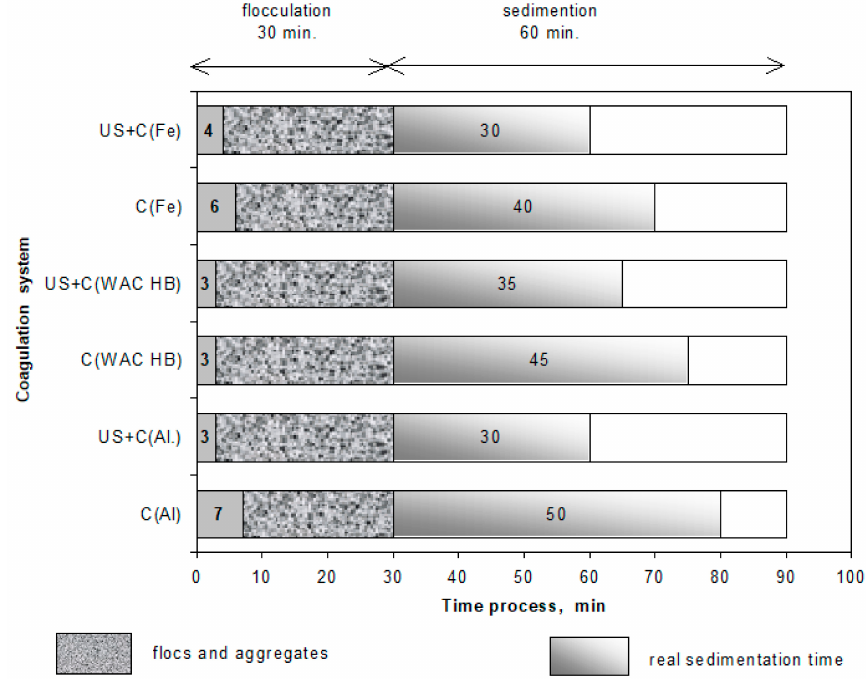
Figure 5. The effect of ultrasound exposure (8 µ m, 5 min) and coagulants on the flocculation process and sedimentation of suspensions .